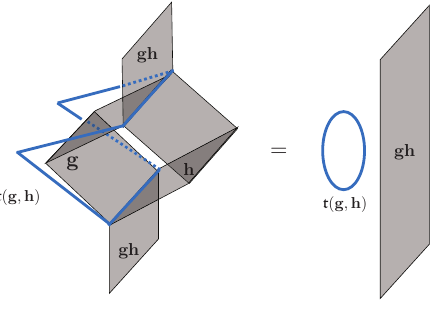
Figure 3: Splitting and fusing defect sheets g and h leaves behind an anyon loop